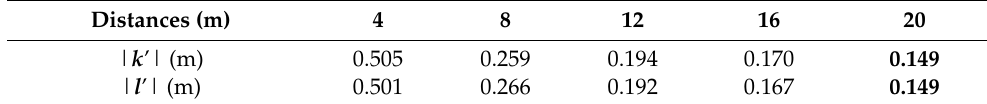
Table 3. The 2D RMSPE ∆ p (m) with varying anchor distances | k | and | l | for the LOS condition.